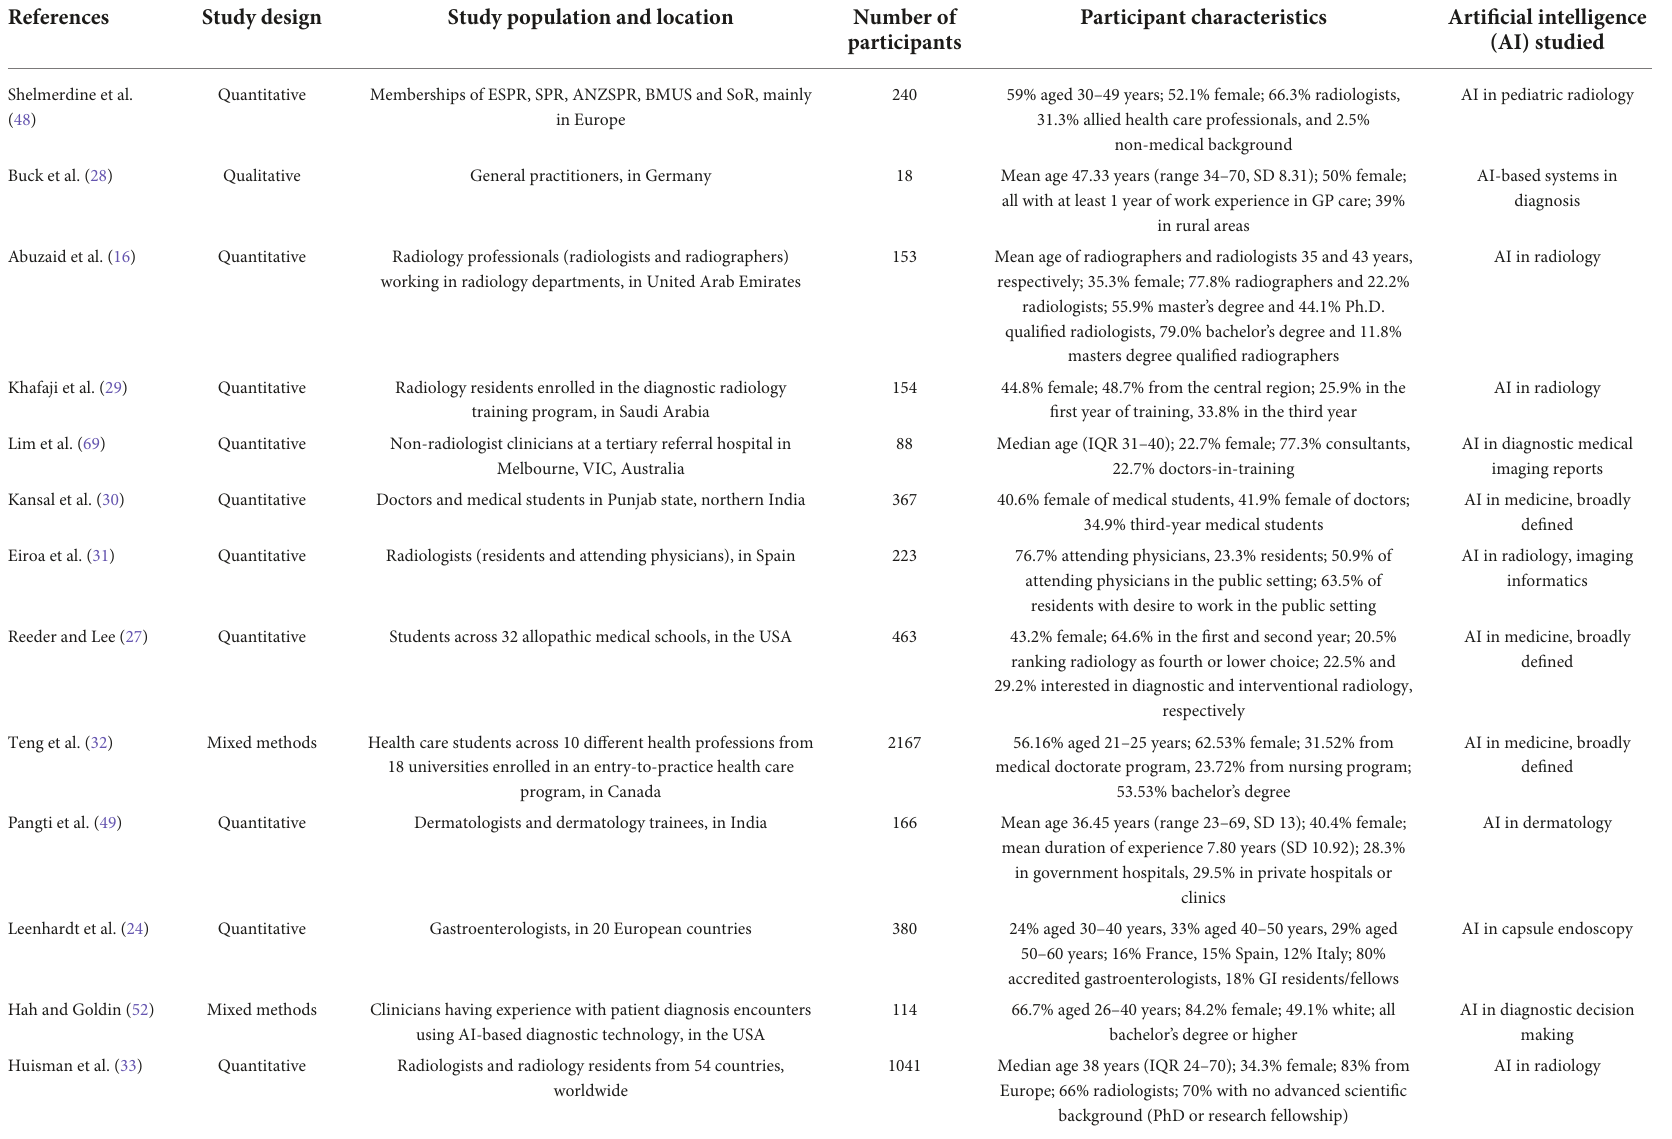
TABLE 1 Characteristics of studies included in the systematic